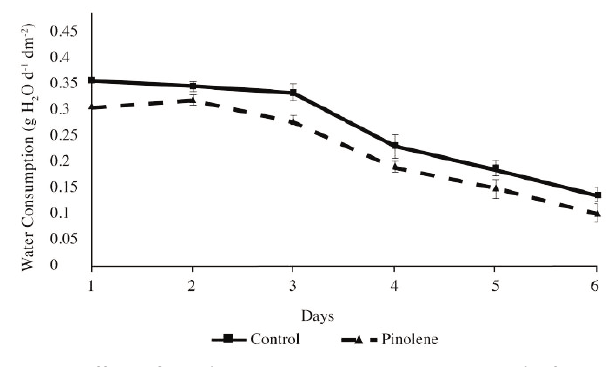
Fig. 3 - Effect of Pinolene on water consumptions per leaf area of rose cut stems during storage. Vertical bars indicate ± SE of means.